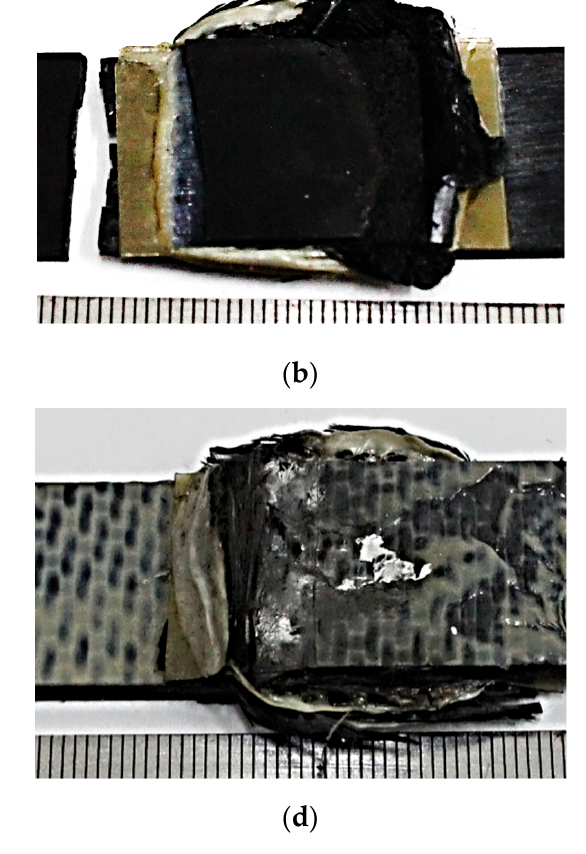
Figure 15. Optical images of the cross sections ( a , c ) and general views of the failed USW lap joints after the tensile tests ( b , d ), obtained with modes 12 (particulate composite adherends, ( a , b )) and 13 (laminate composite adherends, ( c , d )). Table 10. The dimensional characteristics of the USW lap joints with the CFF prepreg between the